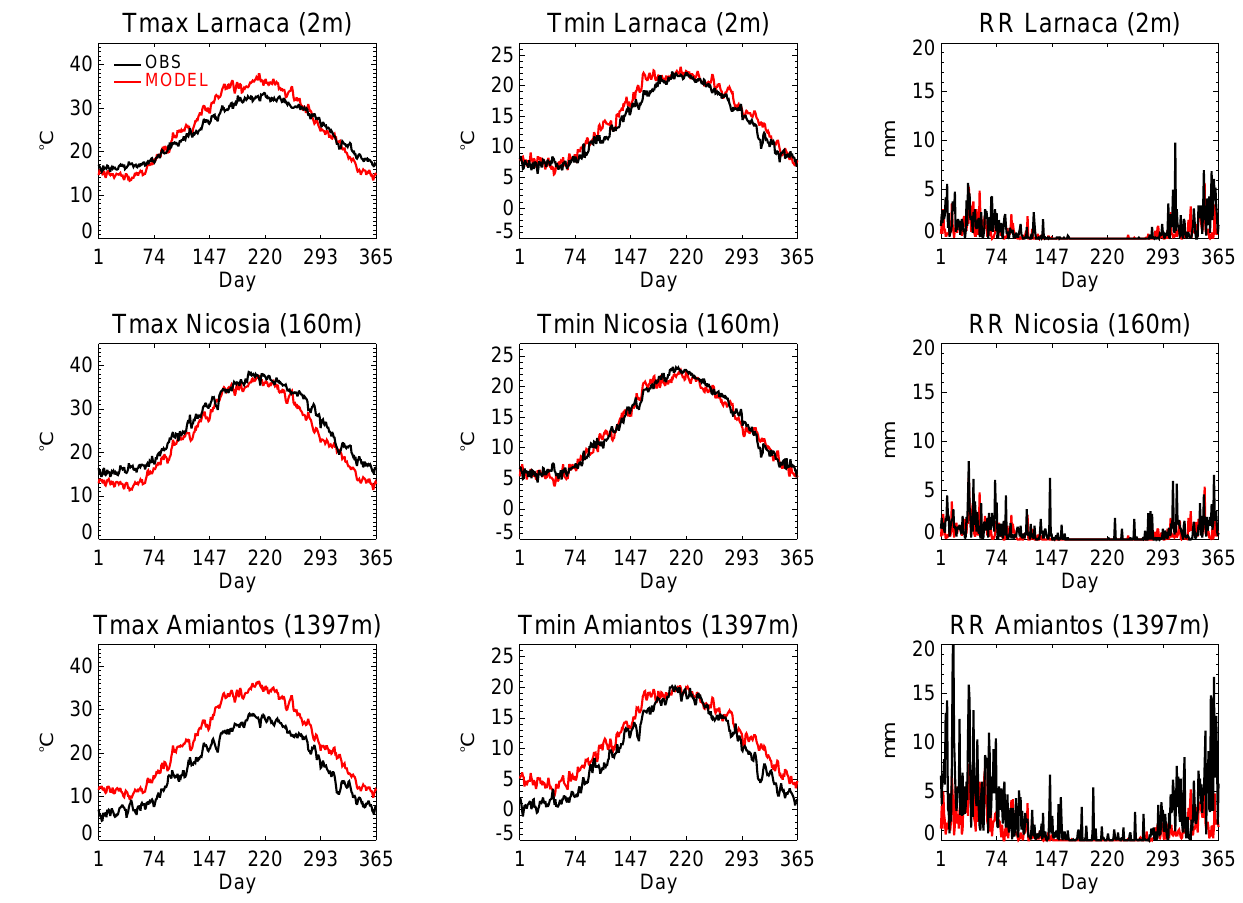
Fig. 1. Curves show the 30-year mean annual cycles of observed (black) and modelled (red) maximum (left), minimum temperature (middle) and precipitation (right) at three representative stations. Temperature is measured in ◦ C and precipitation in